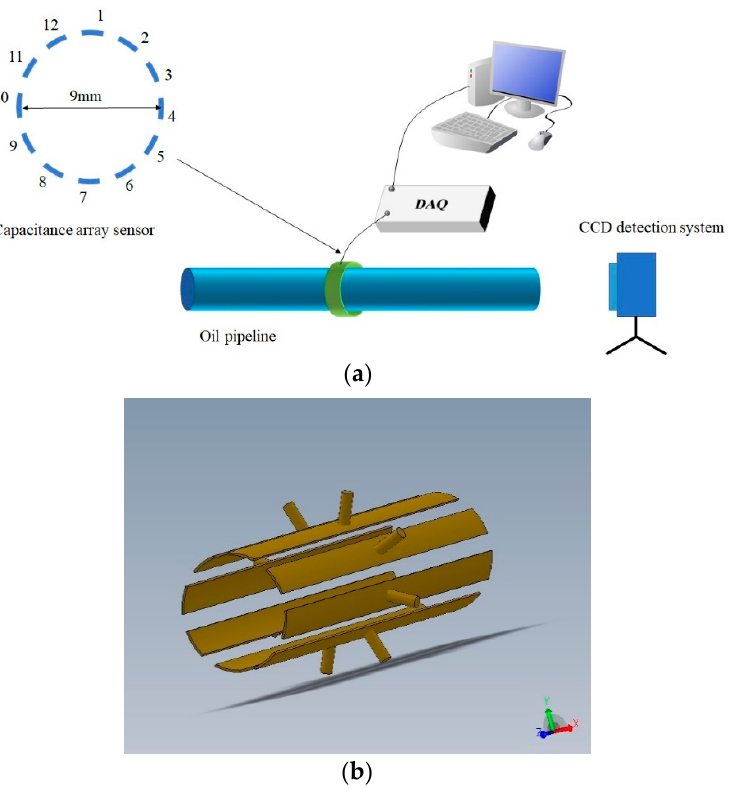
Figure 8. Experimental set-up. ( a ) Detection system in the experiment. ( b ) 3-D model of capacitance array sensor.